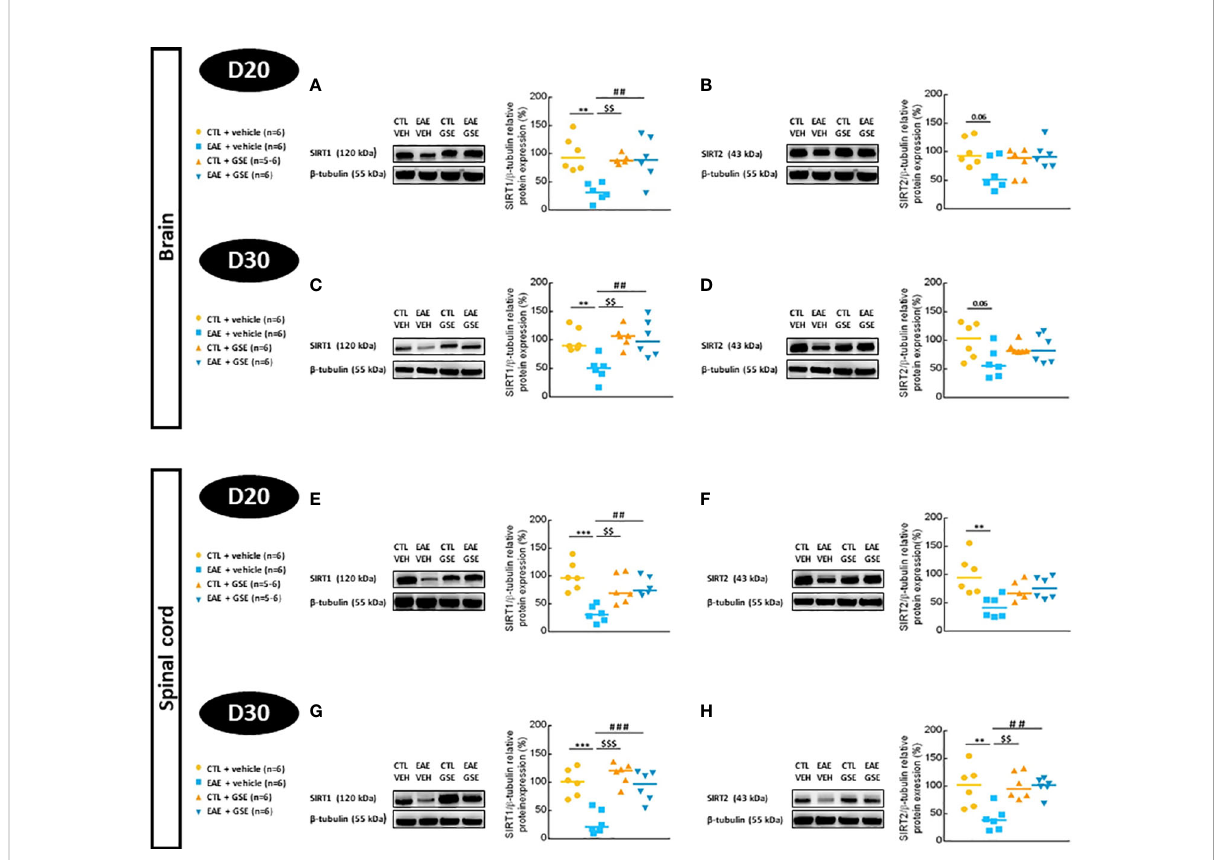
FIGURE 9 Evaluation of sirtuin 1 (SIRT1) and sirtuin 2 (SIRT2) protein expressions in the brain and spinal cord of experimental autoimmune encephalomyelitis mice (EAE) and their controls (CTL) after curative treatment with grape seed extract (GSE) or vehicle. SIRT1/ b -tubulin protein expression was expressed as the relative protein expression (%) compared to CTL + vehicle group, in the brain (A, C) and the spinal cord (E, G) at D20 (A, E) or D30 (C, G) post-induction. SIRT2/ b -tubulin protein expression was expressed as the relative protein expression (%) compared to CTL + vehicle group, in the brain (B, D) and the spinal cord (F, H) at D20 (B, F) or D30 (D, H) post-induction. For each protein level quanti fi cation, a representative Western blotting image of the target protein and loading control is proposed. Statistical analysis was performed using one-way ANOVA followed by Tukey ’ s multiple comparison test: **p < 0.01, ***p < 0.001 EAE + vehicle vs CTL + vehicle; ##p < 0.01, ###p < 0.001 EAE + GSE vs EAE + vehicle and $$p < 0.01, $$$p < 0.001 EAE + vehicle vs CTL +